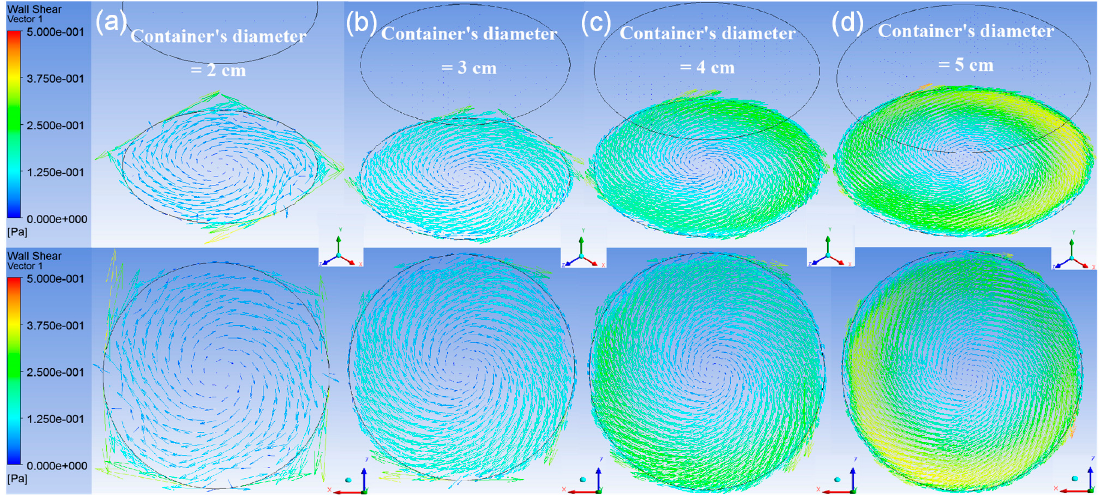
Figure 6. The isometric view and top view of the shear stress distribution on the bottom surface of the container. The shaker’s rotational diameter and the rotational speed are 1 cm and 120 rpm. The inner diameter of the container is adjusted to be ( a ) 2 cm, ( b ) 3 cm, ( c ) 4 cm, and ( d ) 5 cm respectively from left to right. The length of the arrow scale on each image changes with the inner container’s diameter. The coordinate is X ’ YZ ’ system.